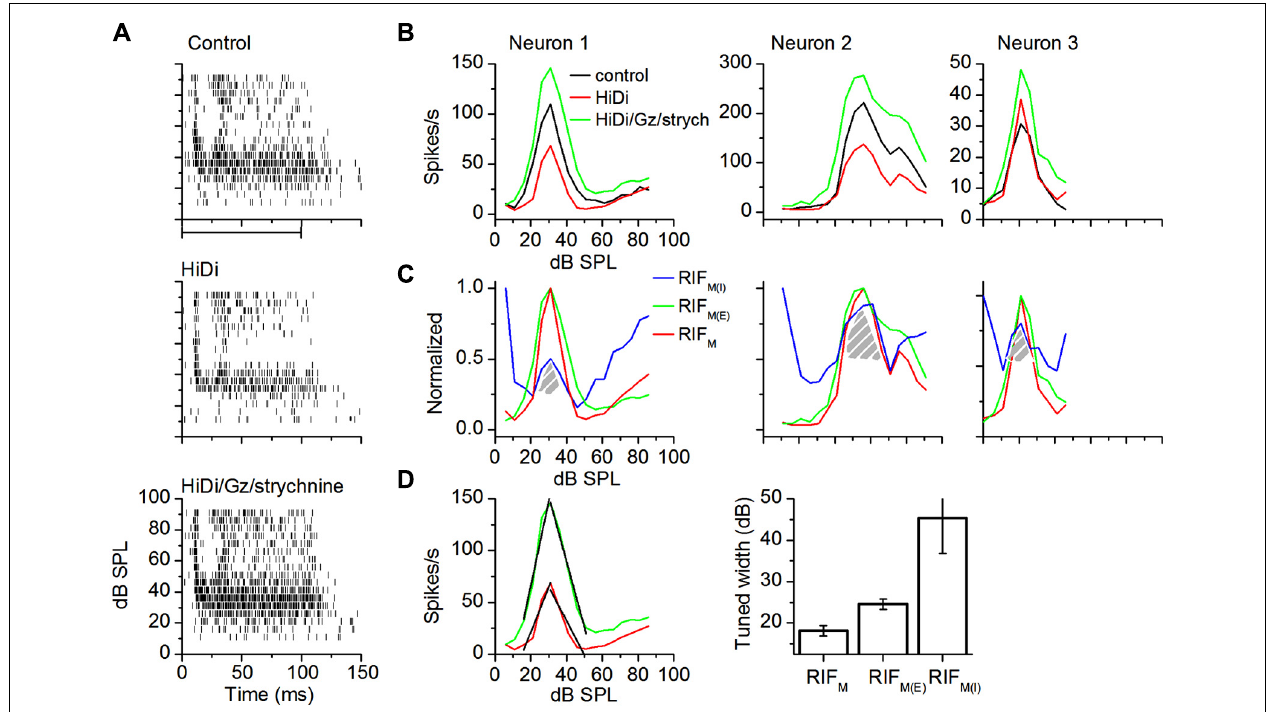
FIGURE 6 | Monosynaptic excitation and inhibition in intensity-tuned neurons. (A) Spike rasters in control (top); HiDi (middle); HiDi + Gz + strychnine (bottom). (B) RIFs for the three neurons. Left: the cell in (A) ; middle, right: two other cells. (C) Normalized RIF M , RIF M ( E ) , and Gain M ( I ) for the three cells in (B) . Gain M ( I ) changes the direction of its gain control with sound intensity. Hatched region: Gain M ( I ) exhibits a “tuned” gain. (D) Left: